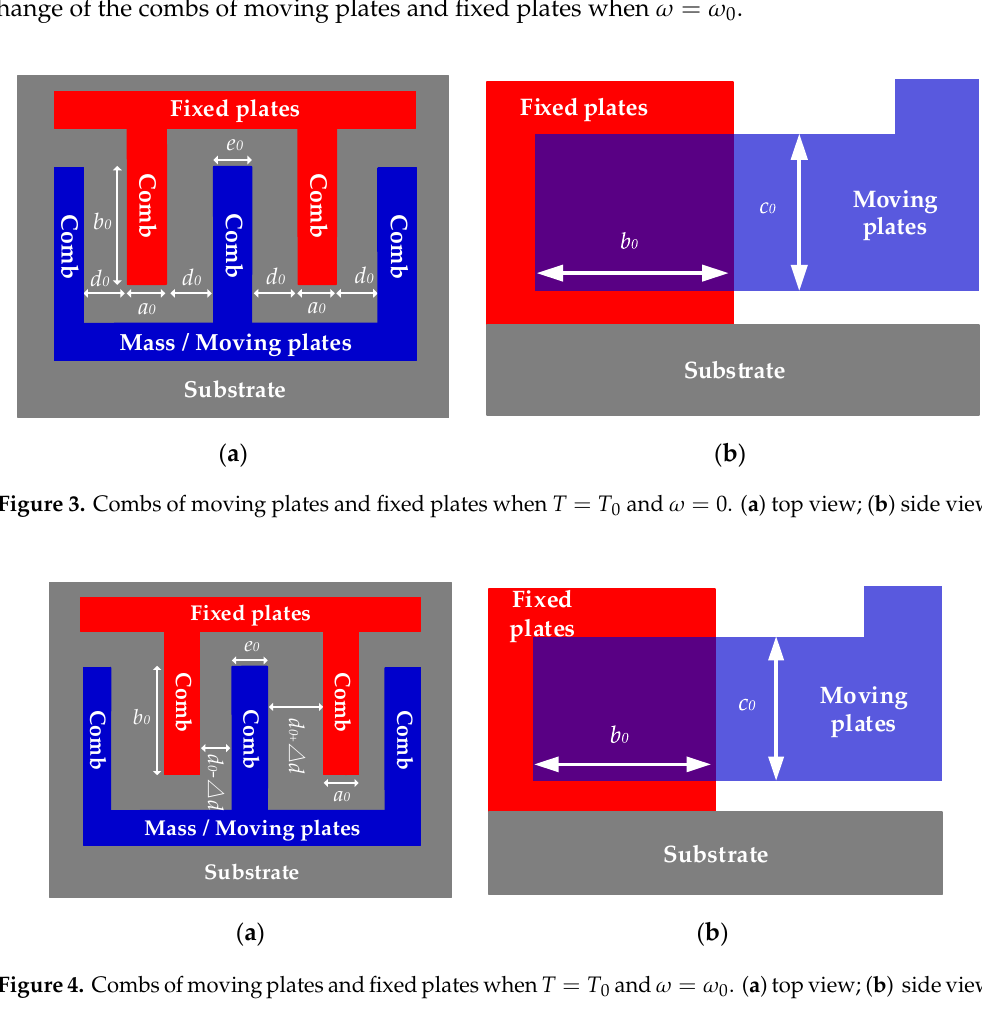
Figure 3. Combs of moving plates and fixed plates when and